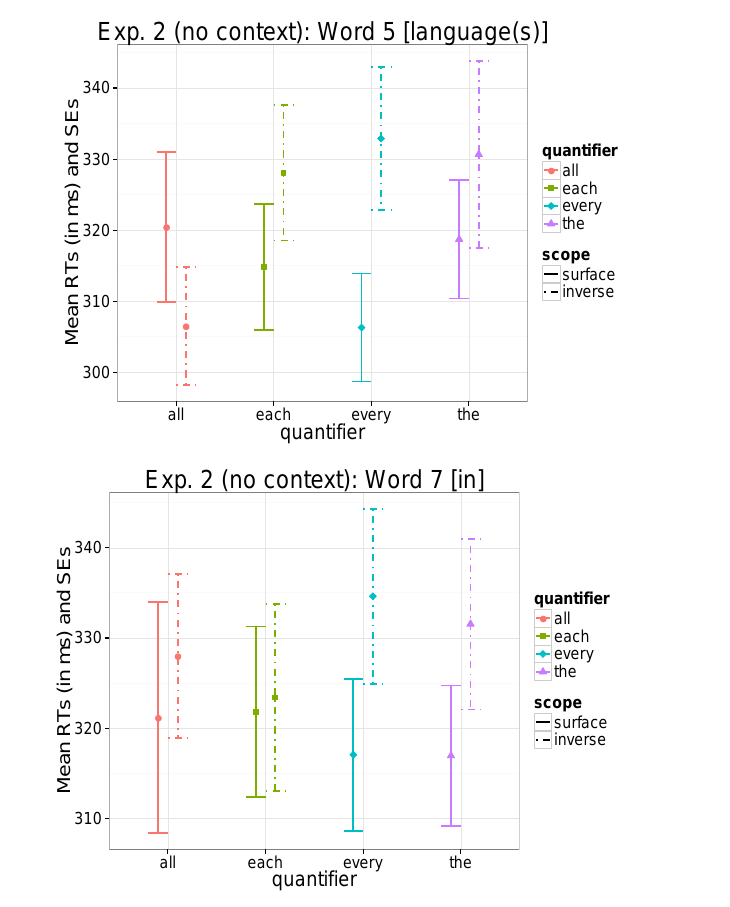
Figure 10 Mean RTs and SEs for Word 5 and Word 7 in Experiment 2 (no